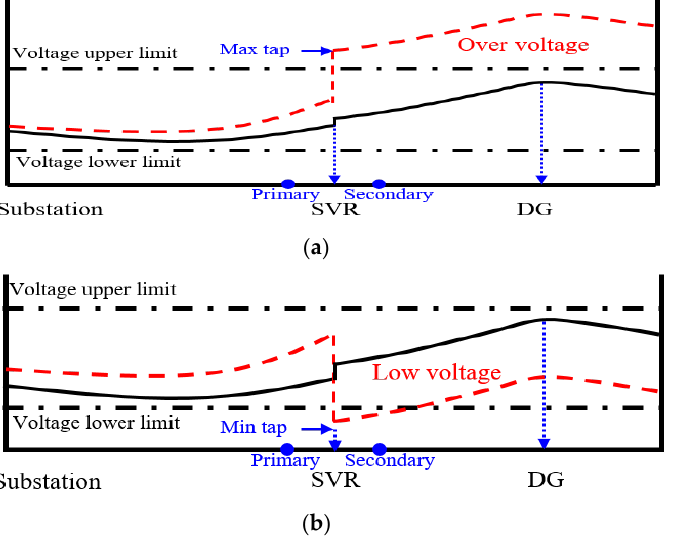
Figure 3. Voltage Profiles under Bi-directional Mode: ( a ) Over-voltage Case; ( b ) Low-voltage Case.